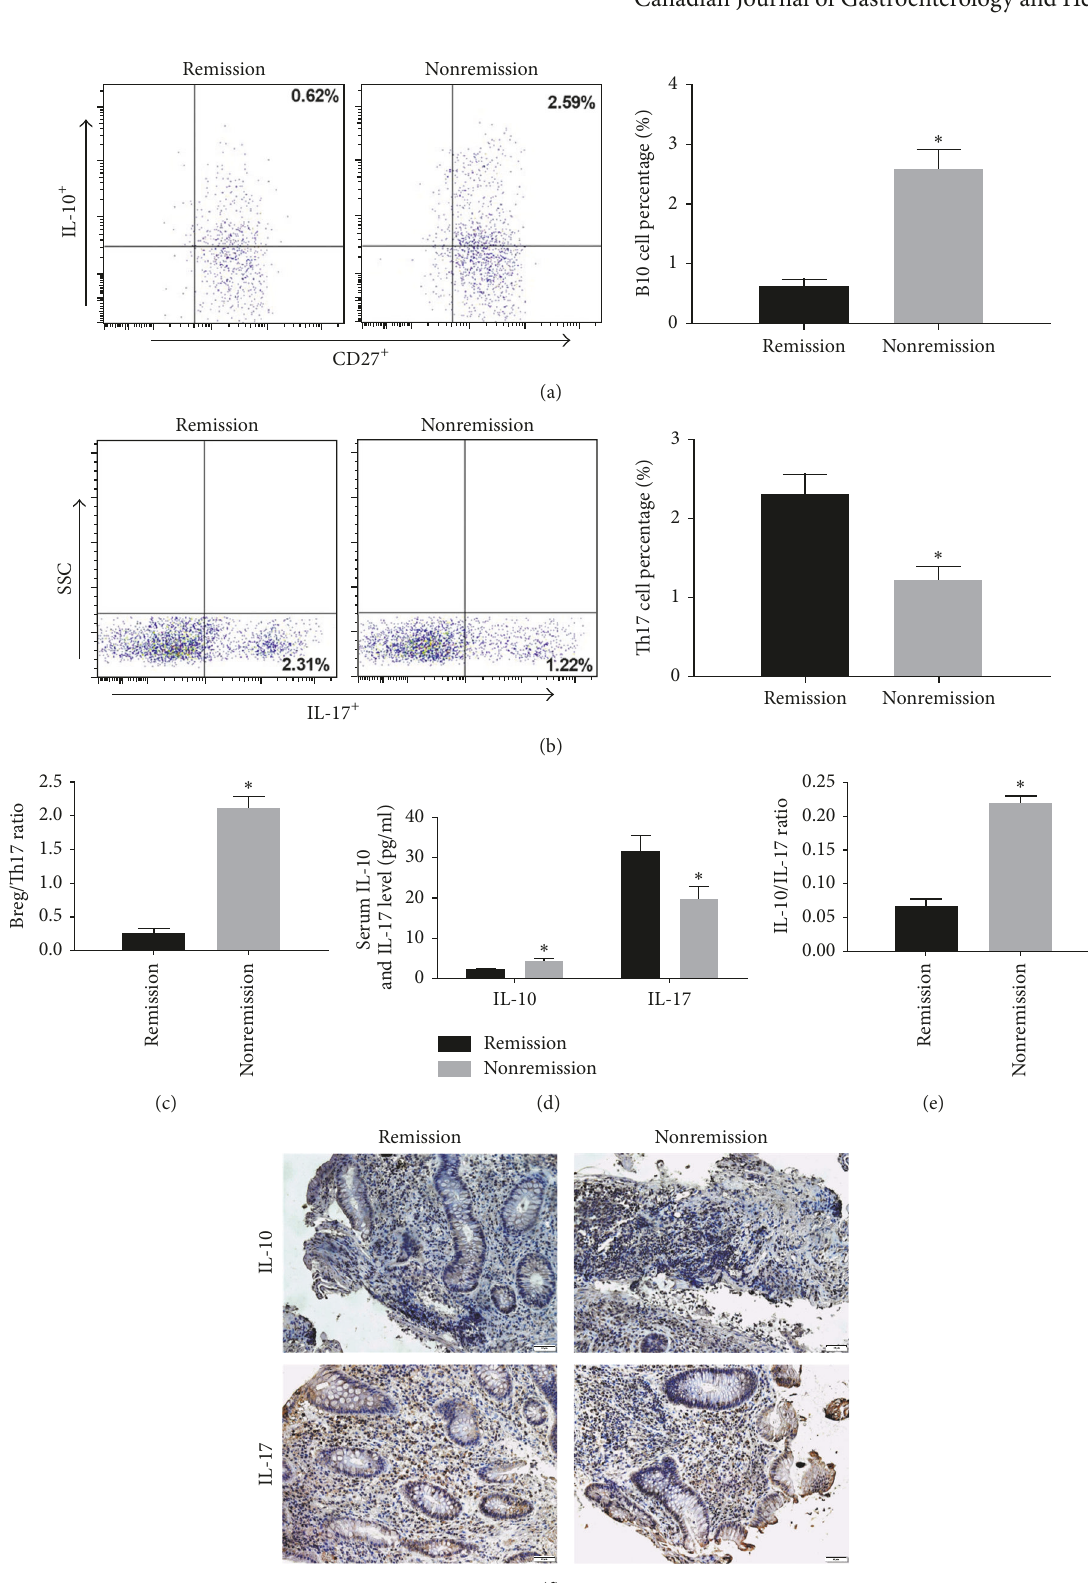
Figure 5: The differences in the cell counts and related cytokine levels between ulcerative colitis patients in remission and nonremission after treatment were analyzed with flow cytometry and ELISA. (a) Gating criteria to define the CD24 + CD27 + CD38 + IL-10 + Breg cell population in the remission group and nonremission group. (b) The percentage of Th17 cells in the remission group and nonremission. (c) B10/Th17 ratio in the remission group and nonremission group. (d) Serum IL-10 levels and IL-17 levels were detected with ELISA. (e) The IL-10/IL-17 ratio in the remission group and nonremission group. (f) IL-10 and IL-17 expression by immunohistochemistry in in the remission group and nonremission group. Compared with remission group, ∗ 𝑃 < 0.05